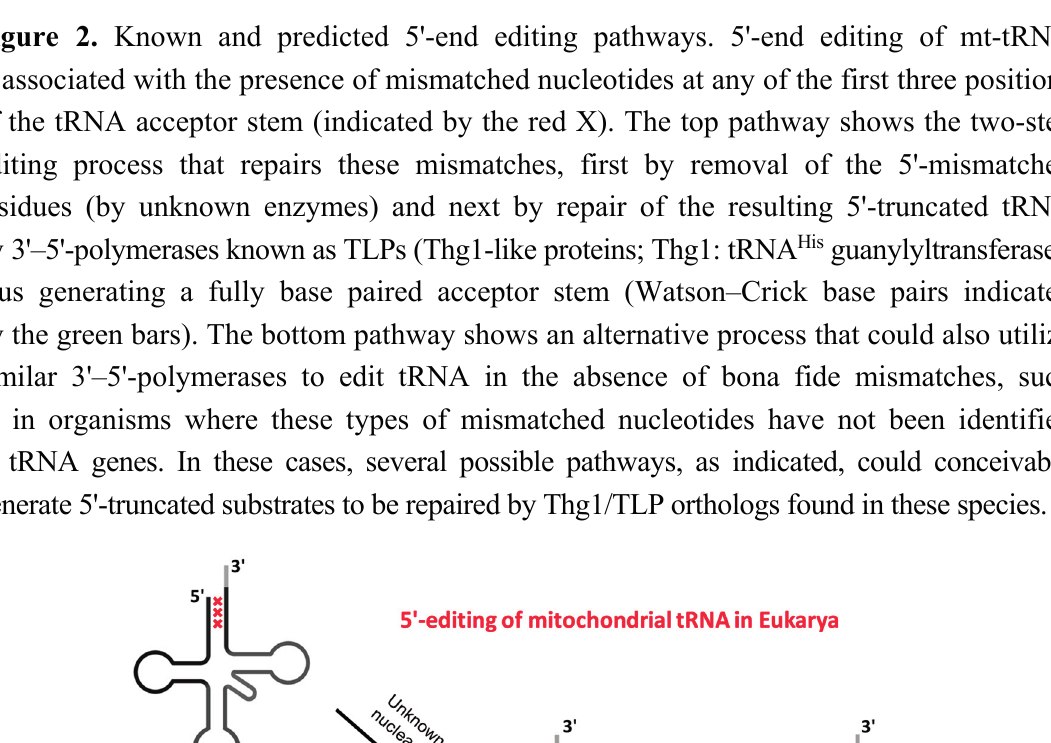
Figure 2. Known and predicted 5'-end editing pathways. 5'-end editing of